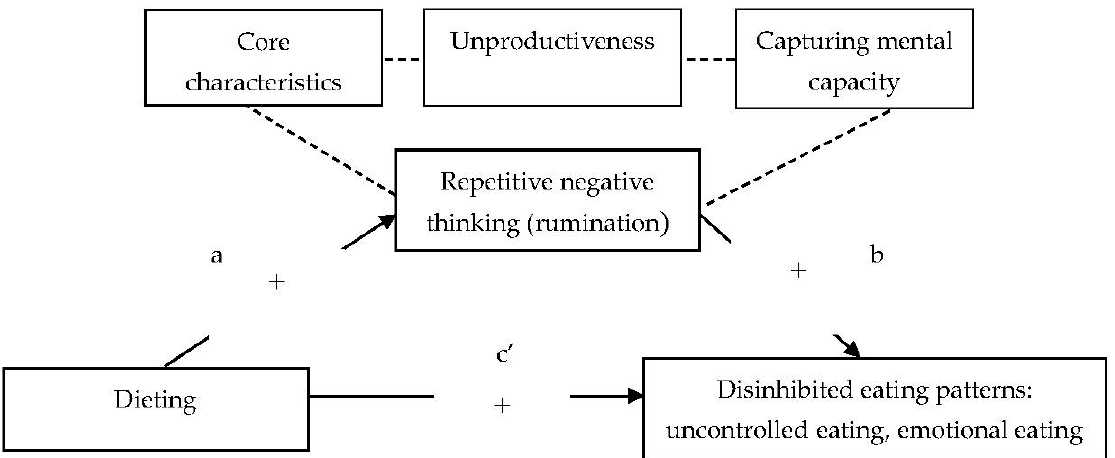
Figure 1. Hypothesized mediation model for relationship between dieting, rumination and both emotional eating and uncontrolled eating in women with normal body weight. Note: + positive prediction.